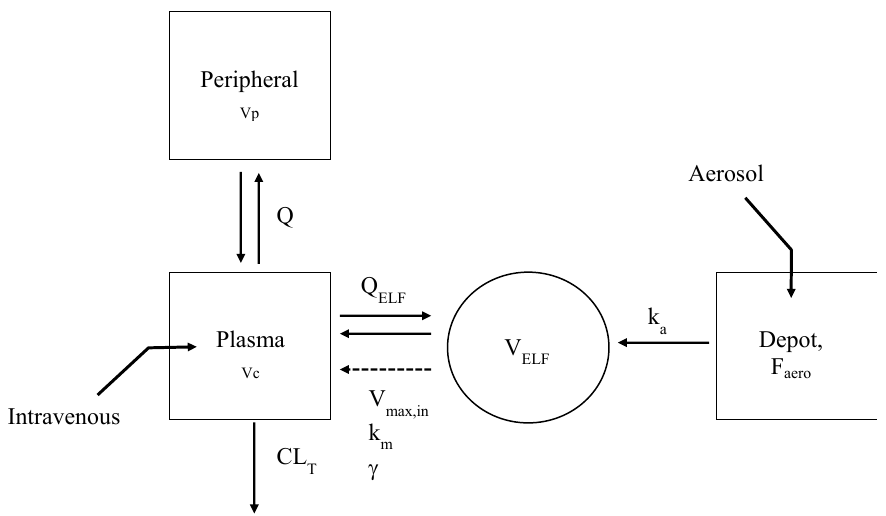
Figure A3. Structural model for the PK analysis.